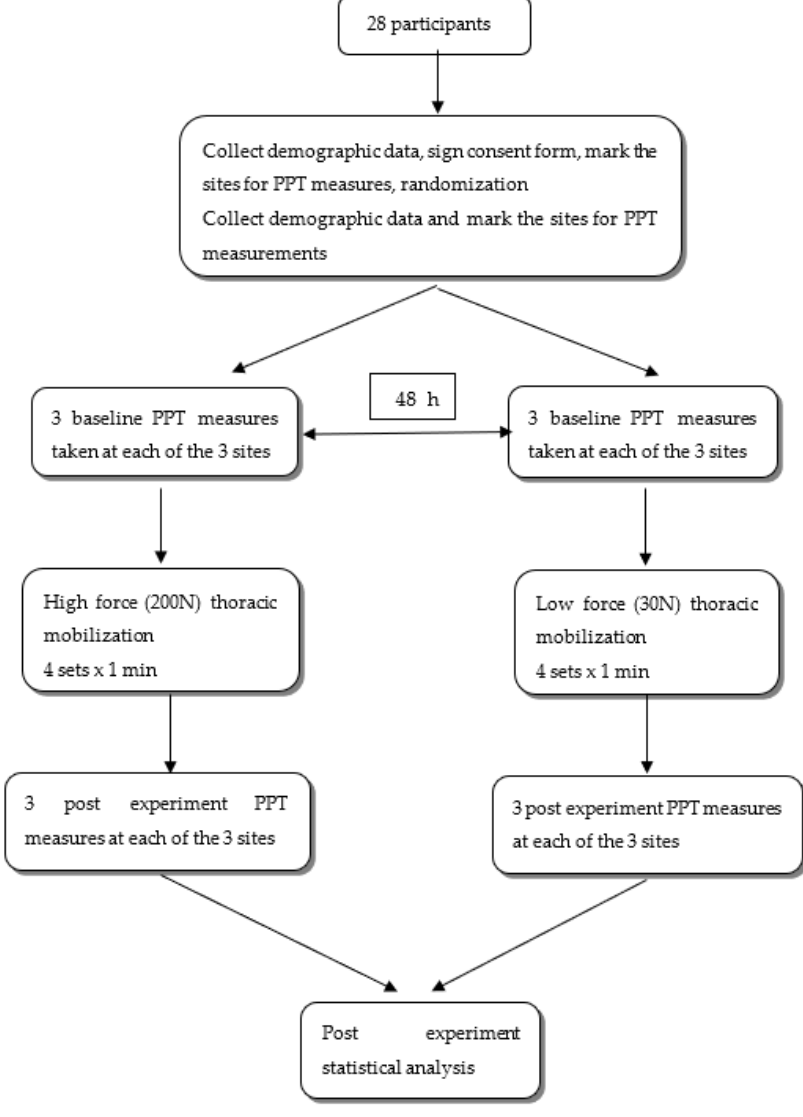
Figure 2. The experimental procedure.